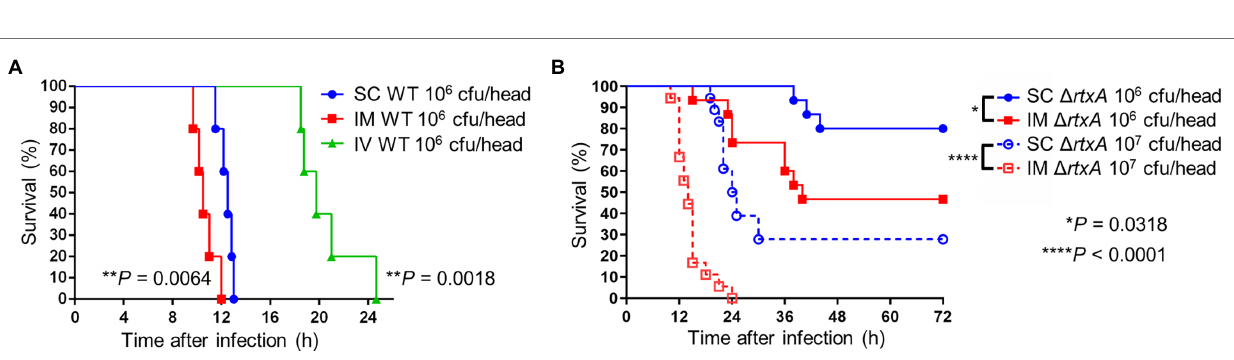
FIGURE 6 | (A) Bacterial burdens in the muscle of mice subcutaneously inoculated with CMCP6 wild type (WT) calculated as CFU/g during 2 h time course. (B) Bacterial burdens in the muscle and the spleen of mice subcutaneously inoculated with CMCP6 WT, and Δ rtxA calculated as CFU/g at 12 h post-infection. Each symbol represents an individual mouse ( n = 6/group). Error bars indicate SEM. * p < 0.05, ** p < 0.01, and *** p < 0.001 compared with WT; Mann–Whitney U -test. Simple Linear Regression Analysis in the right panel of Figure 2C .